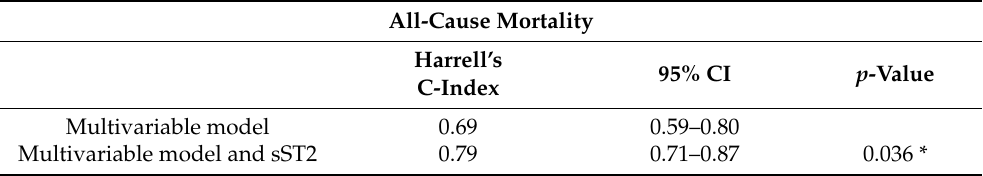
Table 4. sST2 adds prognostic information on top of clinical risk factors in patients with